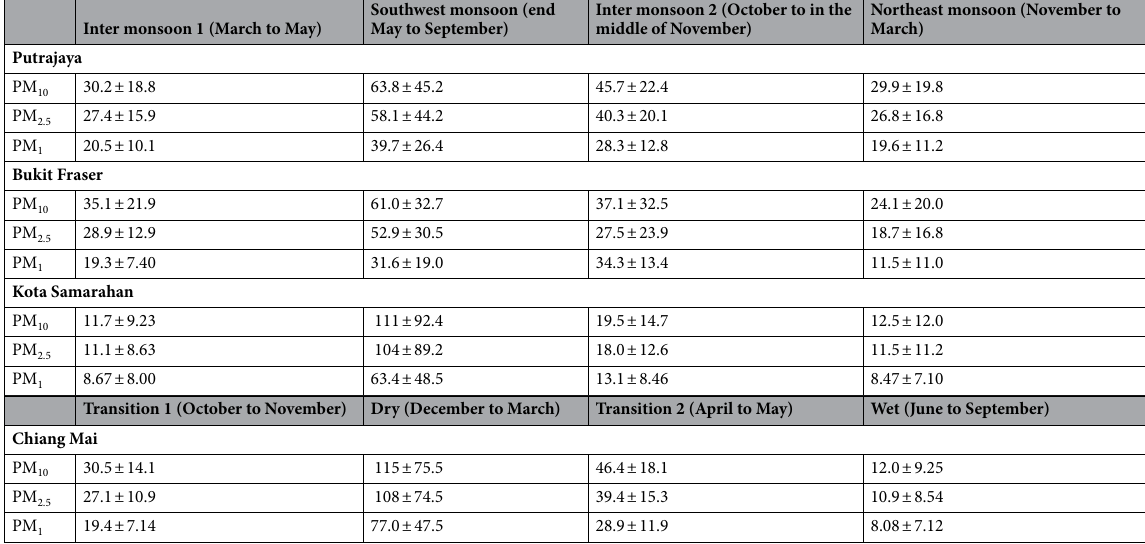
Table 1. Average concentration of PM 10 , PM 2.5 and PM 1 based on different seasons (concentration in µg m −3